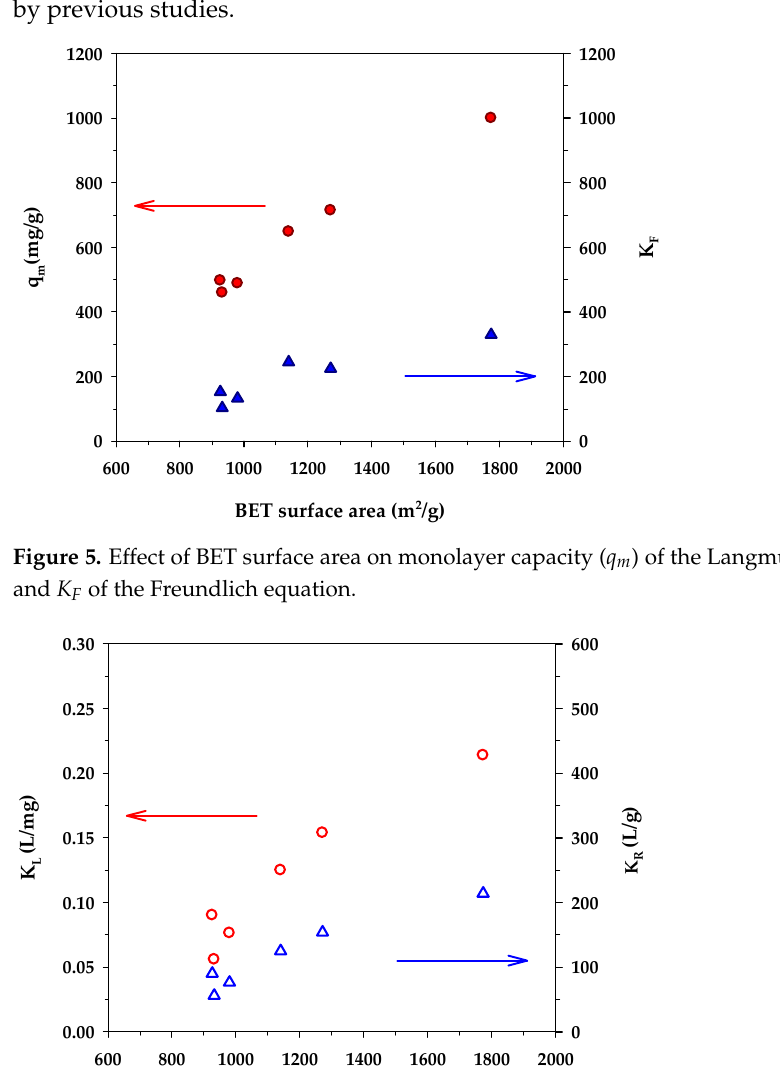
Figure 4. Adsorption isotherms at 35 °C of MB dye on longan seed-activated carbons prepared by ( a ) the two-step activation method, and ( b ) the OTA method.